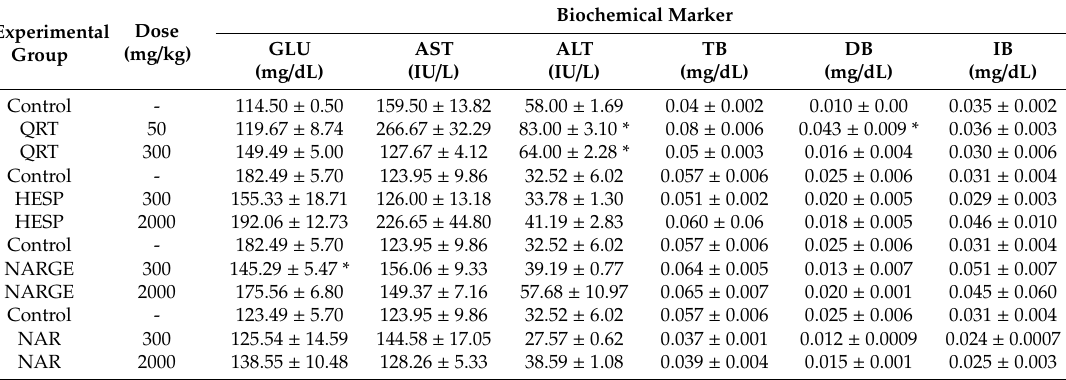
Table 1. Biochemical analysis: values and e ff ects after treatment with several doses of flavonoids. Experimental Group